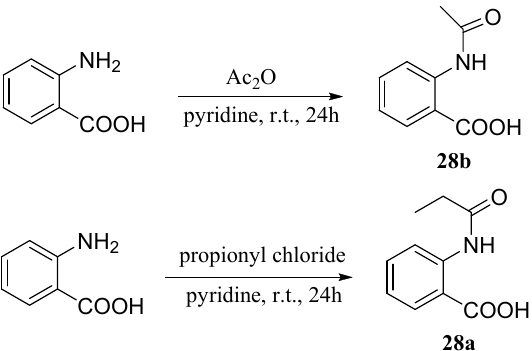
Figure 6. The structures of compounds 28a - 29b